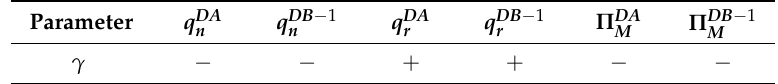
Table 8. The impact of the mandated remanufacturing target on the manufacturer’s decisions. Parameter